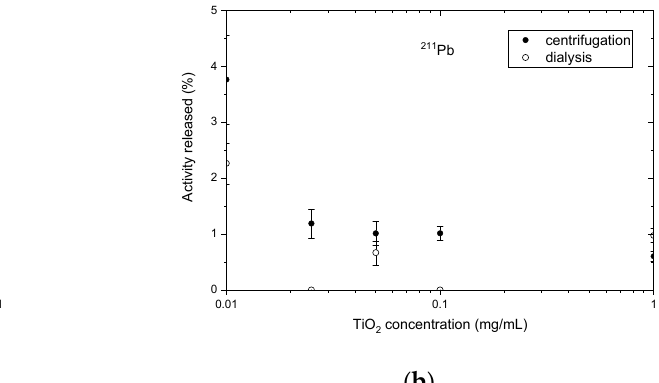
Figure 3. Semi-logaritmic plot of nuclides release vs. nTiO 2 dispersion concentration for ( a ) 211 Bi and ( b ) 211 Pb respectively at 6 h. time-point.